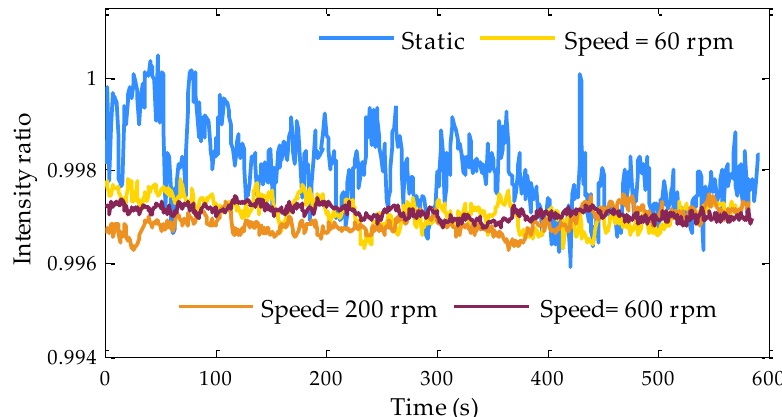
indicates the average of the normalized ratio, and is the standard deviation of the normalized ratio. R I Figure 11. The standard deviation of the normalized intensity ratio as a function of the smoothing time with different motor speeds. Table 2. Correlation coefficients of the normalized intensities between the on and off wavelengths with different motor speeds.